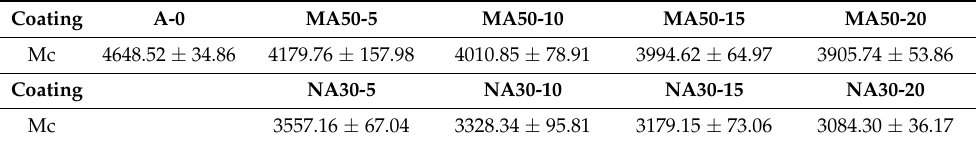
Table 3. Mc values of Al 2 O 3 reinforced coatings.